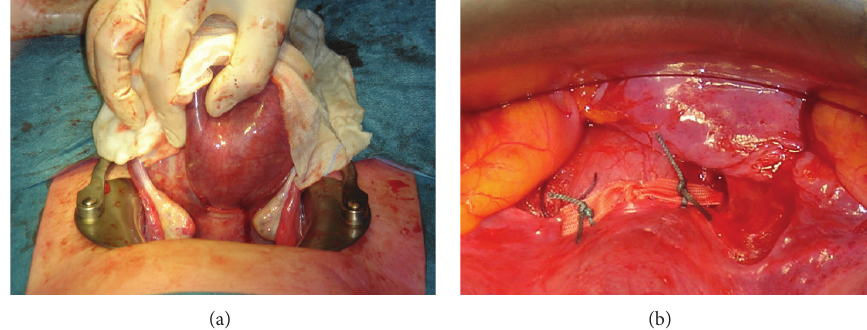
Figure 2: Dorsal (a) and ventral (b) view of the Mersilene band, located at the cervicoisthmic junction. The band is tied on the anterior side of the cervix and the cut ends are fixed to the band with thin nonabsorbable sutures